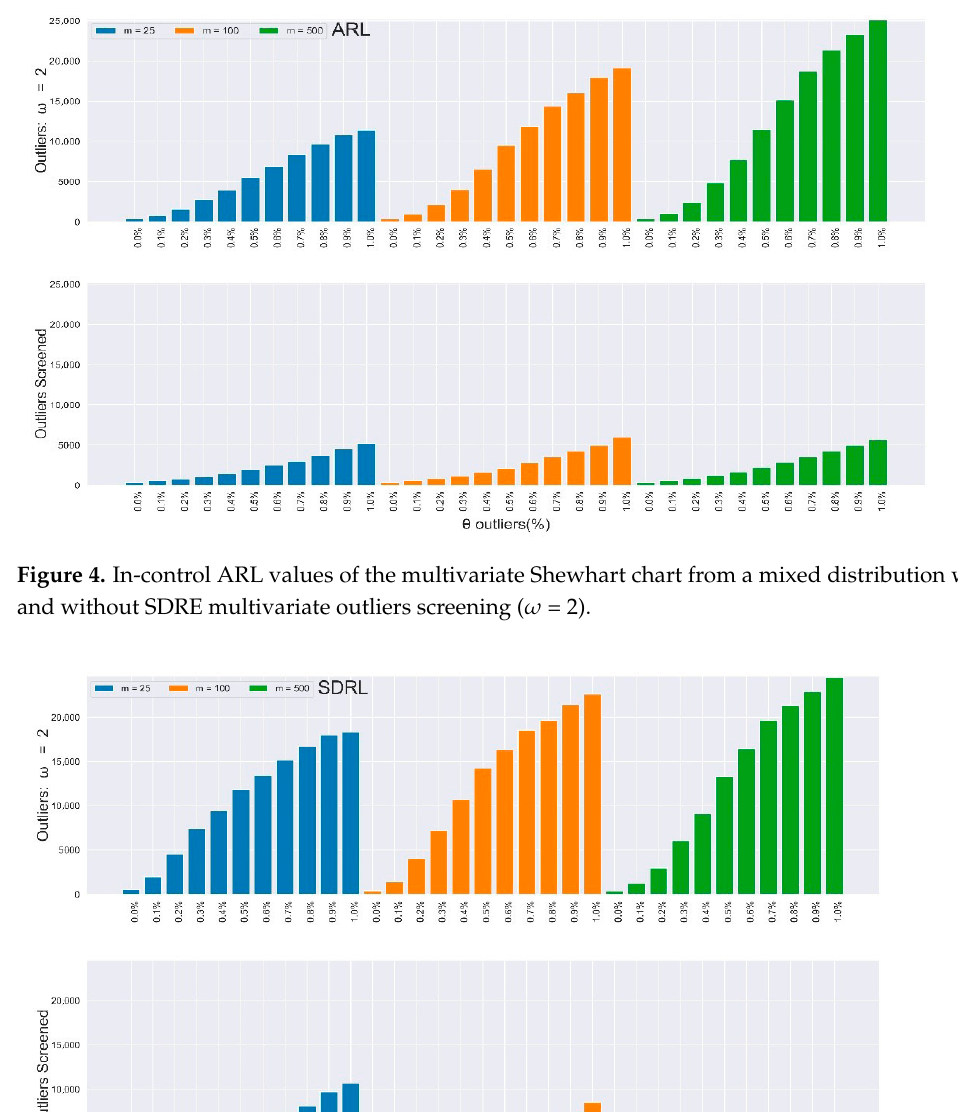
Figure 3. In-control SDRL values of the multivariate Shewhart chart from a mixed distribution with and without SDRE multivariate outliers screening ((cid:2033) = 1) .